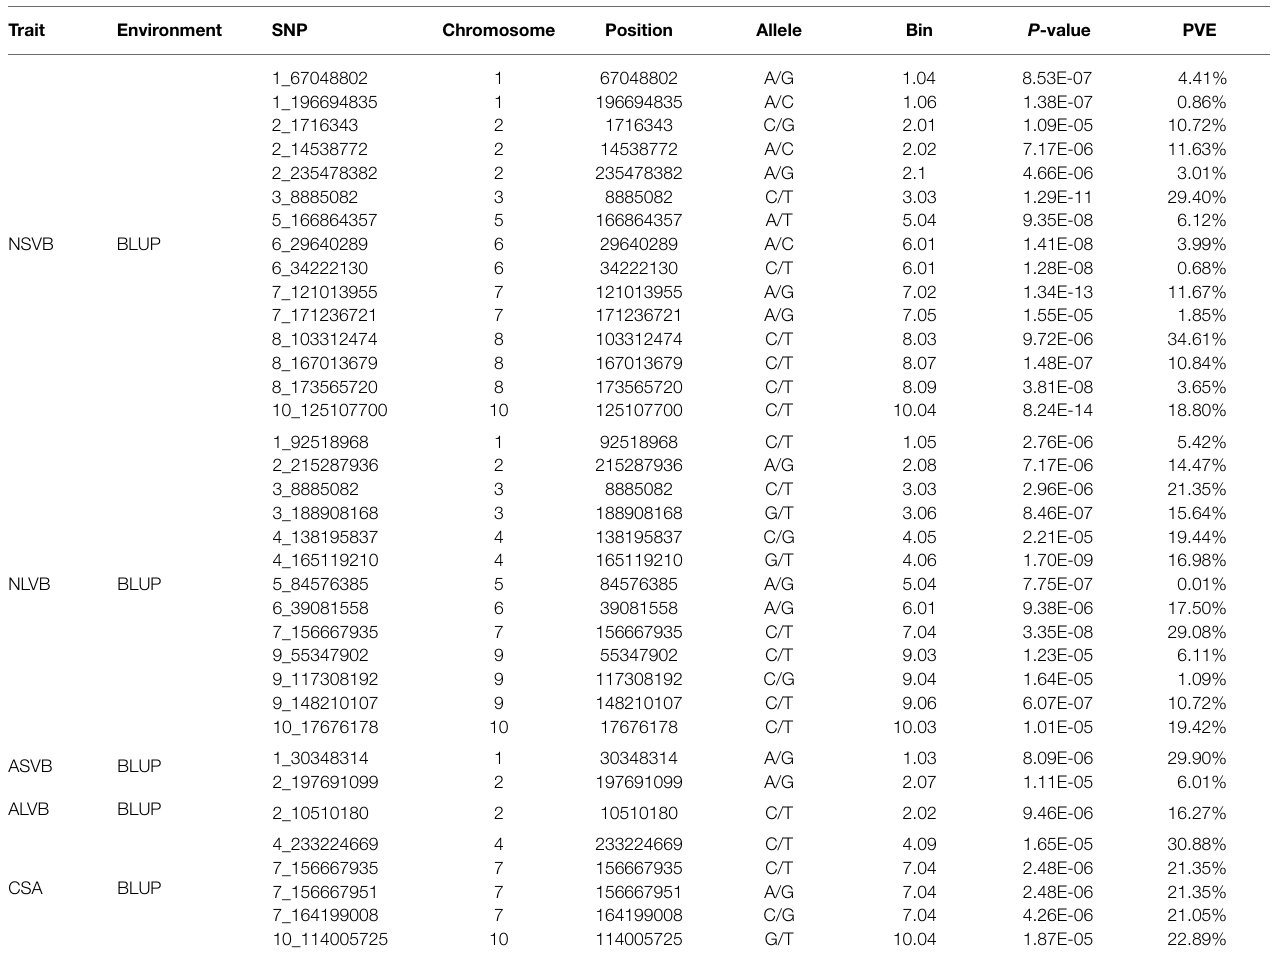
TABLE 3 | Analysis of correlated SNP with vascular bundle-related traits. Trait